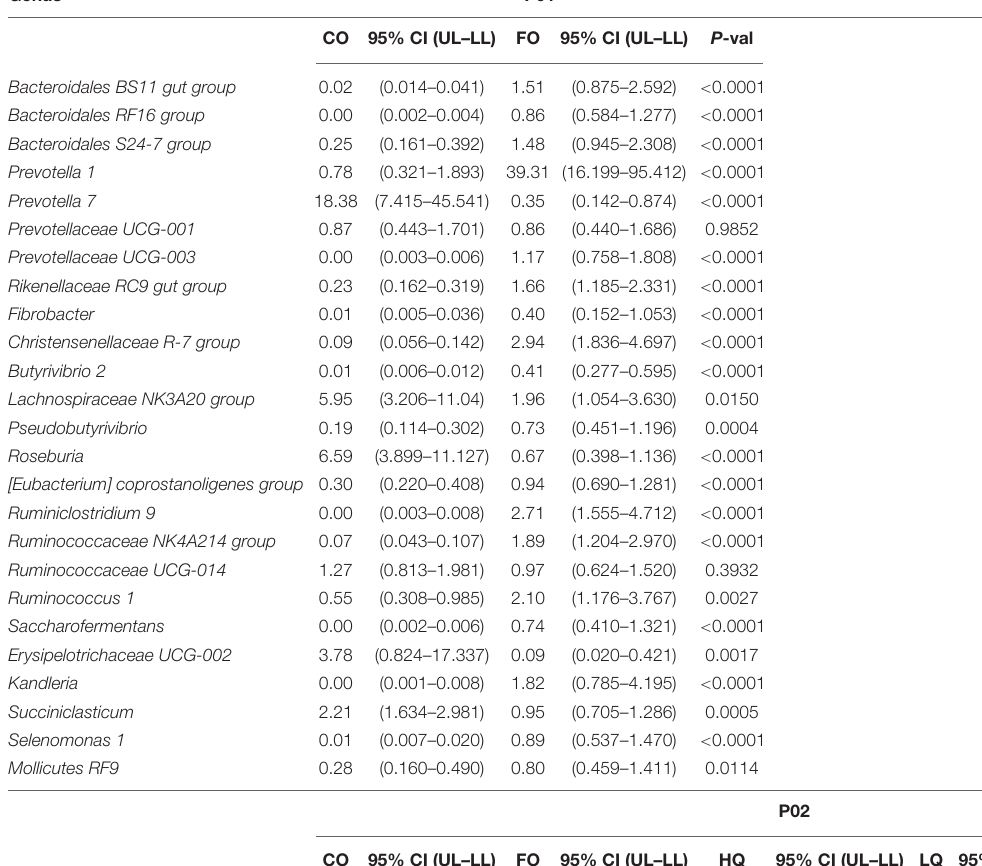
TABLE 4 | Effect of dietary treatments a on the abundant bacteria genus b during the three measurement phases c .